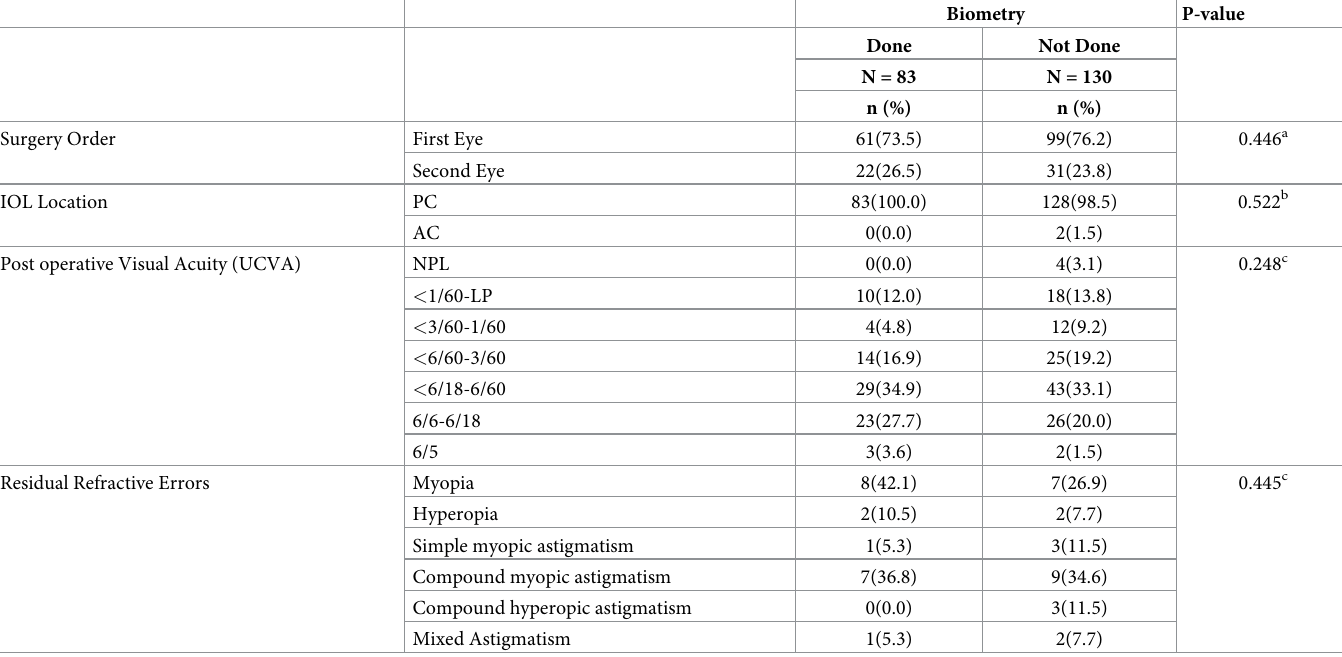
Table 2. Cataract surgical technique used over the years